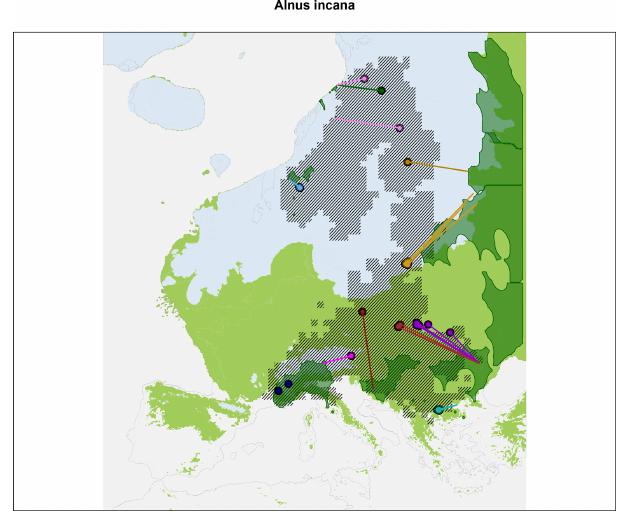
Figure 7. Distribution of Alnus incana in Europe (based on the Atlas Flora Europaea; Jalas and Suominen, 1976) in current times (line shaded/hatched) and reconstructed effective refugia at 17ka (dark-green alpha hull polygons) using dynamic species distribution modeling based on KISSMig and CHELSA-TraCE21k. The entire suitable habitat for A. incana at 17ka is indicated as light green. Al- though almost all of south-central Europe was suitable for A. incana at 17ka, it might not have occurred at all locations due to dispersal constraints, which are considered in the dark-green KISSMig recon- structed distribution. Colored circles indicate the population genetic structure of A. incana , taken from Dering et al. (2016), where each color represents a genetic cluster. Lines indicate the most likely ef- fective refugia a genetic cluster can be associated with, given dis- persal and climatic constraints. Current genetic clustering of popu- lations indicates that the modeling of A. incana distributions at 17ka successfully detected glacial effective refugia in the southern Alps (dark blue), southern Norway (light blue), northern Norway (pink), the Balkans (dark red), eastern Romania (turquoise), and the Black Sea (dark red and violet). As we only use the current distribution of A. incana within the AFE extent the results might be biased outside of